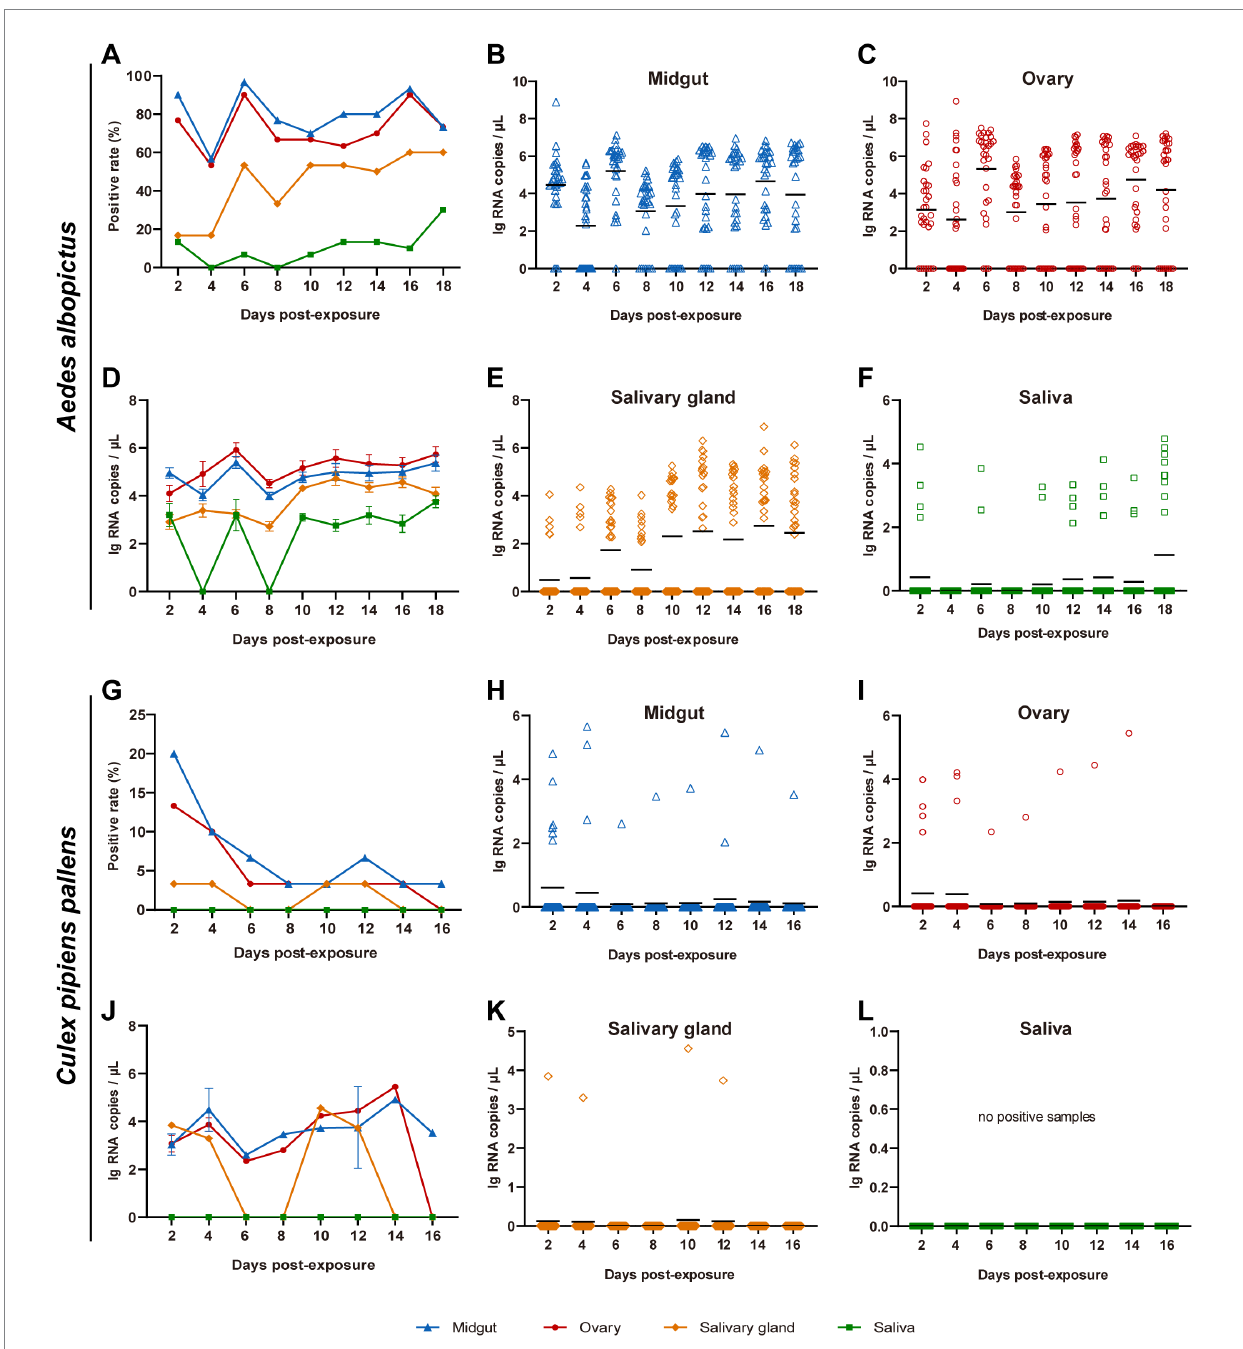
FIGURE 2 Replication potential of TAHV PJ01 strain in Ae. albopictus (A–F) and Cx. pipiens pallens (G–L) . Ae. albopictus and Cx. pipiens pallens were fed artificial virus blood meals containing of TAHV PJ01 strain suspension (50% v/v) and mouse blood (50% v/v). The midguts, ovaries, salivary glands, and saliva were dissected and collected for virus detection at the indicated days ( n = 30). (A,G) Virus positive rate in Ae. albopictus and Cx. pipiens pallens ( n = 30). (B–F,H–L) Viral RNA copy concentration in Ae. albopictus and Cx. pipiens pallens . In panels (B,C,E,F,H,I,K,L) , the black lines represented the means of all 30 samples. In panels (D,J) , data represented the means ± standard error of positive